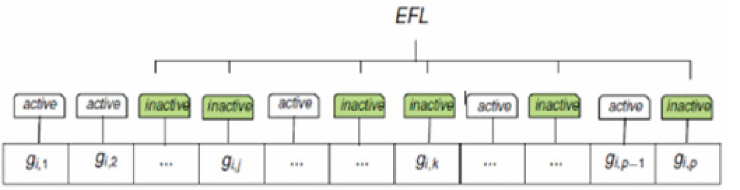
Figure 2. Epigenetic list of the patterns H3K9m3 in a usual tri-cluster with the same pattern in human erythroleukemic cell line (HEC)